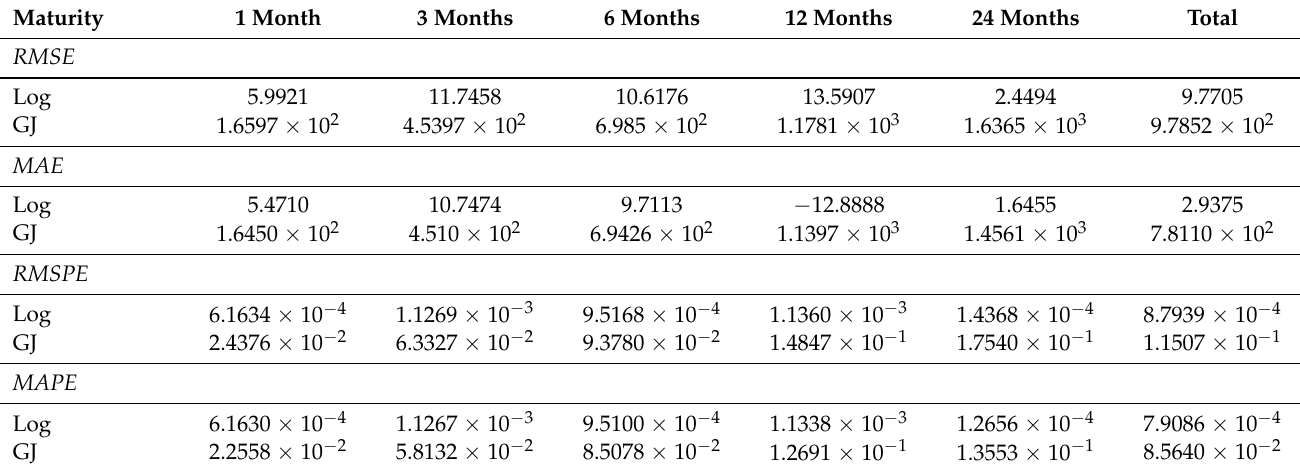
Table 2. Root mean square, mean absolute, root mean square percentage, and mean absolute percentage errors for Log and GJ